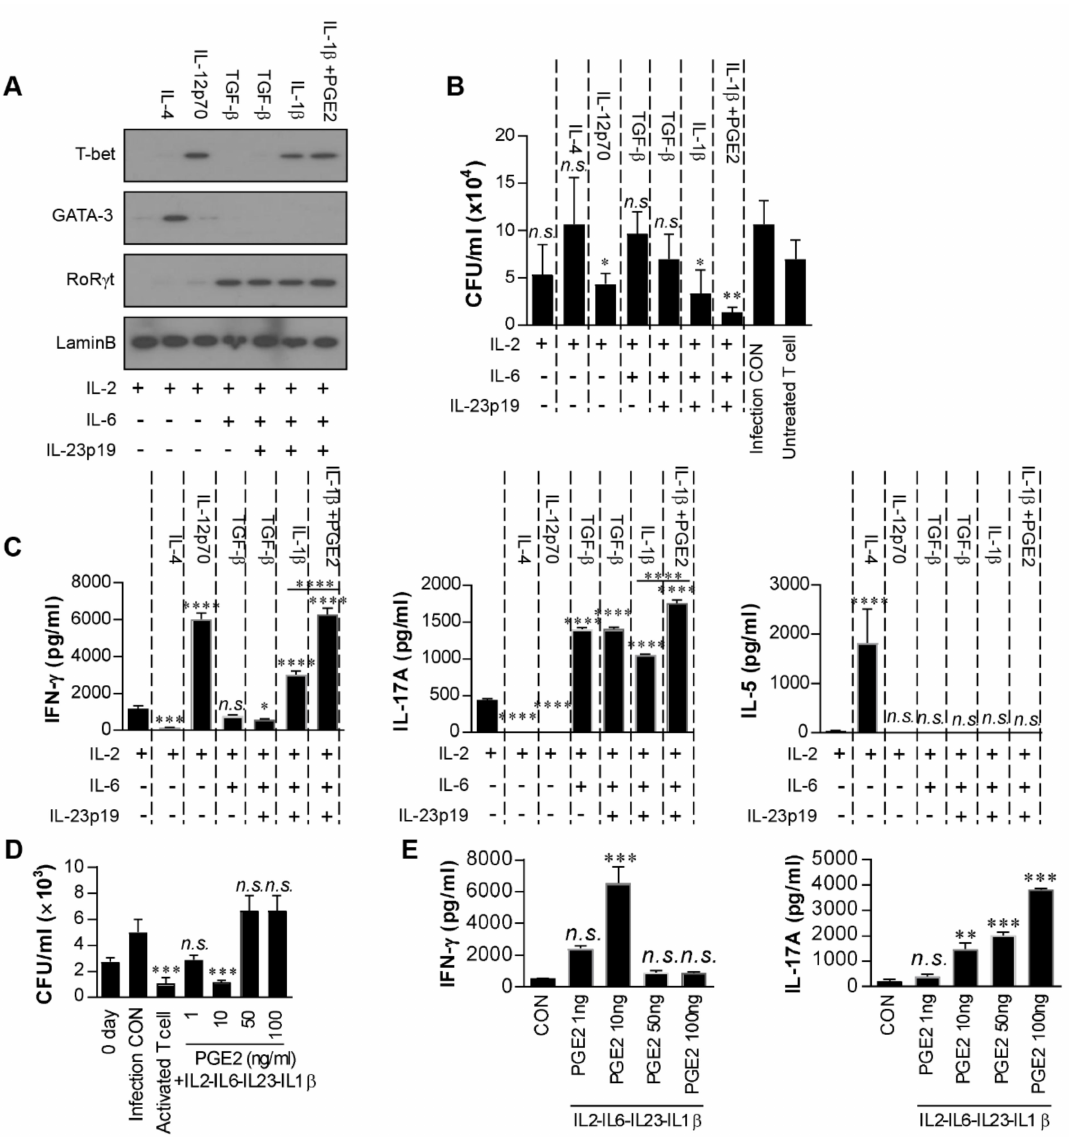
Figure 4. Low-dose prostaglandin E2 (PGE2) promotes Th1/Th17 differentiation in vitro. Naïve CD4 + T cells (1 × 10 6 ) were cultured with cytokines (5 ng/mL IL-2; 25 ng/mL IL-4; 5 ng/mL IL-12; 25 ng/mL IL-6; 250 ng/mL TGF- β ; 50 ng/mL IL-23; 10 ng/mL IL-1 β ; 5 ng/mL PGE2) in 24-well culture plates coated with anti-CD3 antibodies (2 µ g/mL) for 5 days. ( A ) The levels of T-bet, GATA-3, and RoR γ t in differentiated T cells induced by each combination of cytokines were assessed by immunoblotting. ( B ) Differentiated T cells induced by each combination of cytokines were co-cultured with Mycobacterium tuberculosis (Mtb)-infected bone marrow-derived macrophages (BMDMs). Intracellular Mtb growth in the BMDMs was determined after 3 days. All data are expressed as the mean ± SD; * p < 0.05 and ** p < 0.01 for treated samples compared to infection control; n.s. , no significant difference. ( C ) The quantities of IFN- γ , IL-17A, and IL-5 in the culture supernatants were determined using ELISA. ( D , E ) T cells were generated by stimulating naïve T cells with 5 ng/mL IL-2, 25 ng/mL IL-6, 250 ng/mL TGF- β , 50 ng/mL IL-23, 10 ng/mL IL-1 β and PGE2 (1, 10, 50 or 100 ng/mL) for 96 h. All data are expressed as the mean ± SD; * p < 0.05, *** p < 0.001 and **** p < 0.0001 for treated samples compared to IL-2 treated T cell; n.s. , no significant difference. ( D ) These T cells were co-cultured with Mtb-infected BMDMs. Intracellular Mtb growth in the BMDMs was determined after 3 days. Activated T cell was positive control and T cells activated by RpfE-matured DCs. Data are the mean ± SD from three independent experiments; *** p < 0.001 compared to infection control. n.s. : no significant difference. ( E ) The culture supernatants were determined using ELISA. Data are the mean ± SD from three independent experiments; ** p < 0.01 and *** p < 0.001 vs. appropriate controls. n.s. : no significant